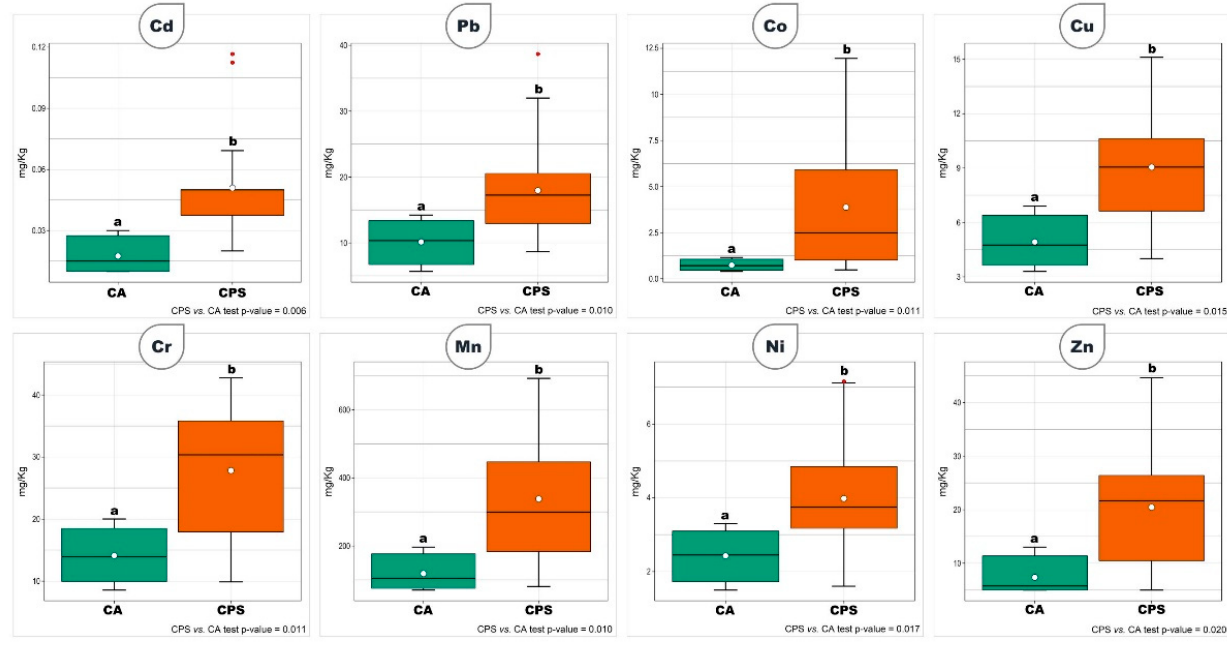
Figure 2. Boxplot of PTM concentrations by sampled environments: Cement Plant Surroundings (CPS) and Control (CA). Figure 2. Box plot of PTM concentrations by sampled environments: Cement plant surroundings (CPS) and control (CA). Wilcoxon tests p -values (CPS vs. CA) were described on the lower right corner. Different letters above boxplots represent Wilcox on tests’ p -values (CPS vs. CA) were described in the lower right corner of each box. Cd = Cadmium, Pb = Lead, significant differences in compared mean values by Wilcoxon Co = Cobalt, Cu = Copper, Cr = Cromium, Mn = Manganese, Ni = Nickel, Zn = Zinc.